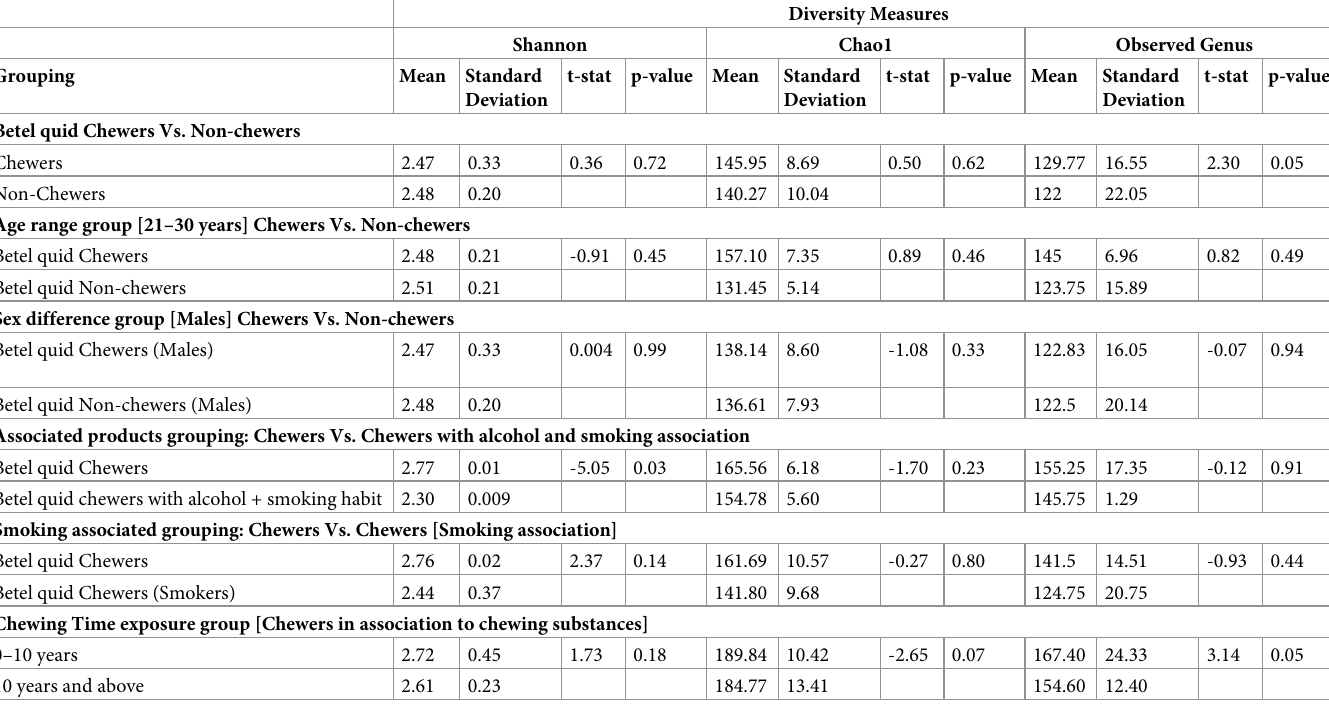
Table 3. Comparison of within-sample (alpha) diversity to bacterial microbiome based on the study